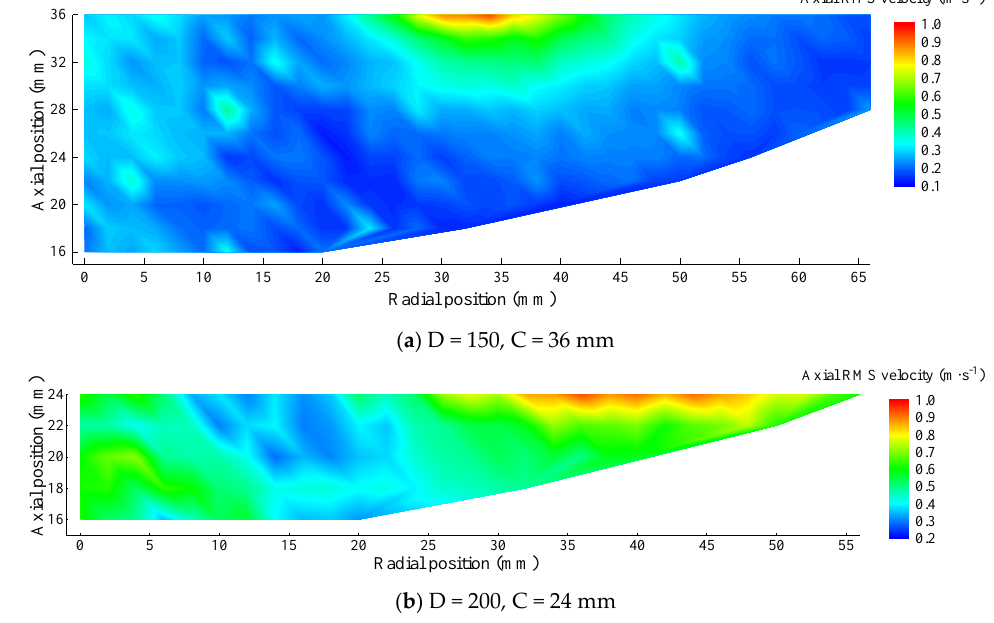
Figure 9. Axial root mean square (RMS) velocity distribution in the centripetal flow.